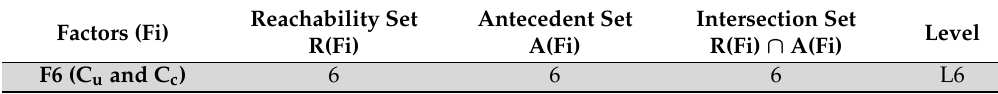
Table A8. Level partition—Iteration